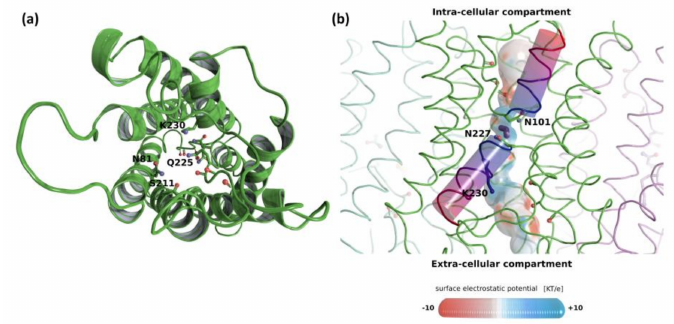
Figure 2. Structural analysis of Triat XIP. ( a ) Schematic representation of one protomer of Triat XIP as seen from the extra-cellular compartment. The backbone is represented in a diagram and the pore lining residues in sticks. Residues of the ar/R SF constriction are labeled. K230 is unusual as it replaces the very conserved Arginine of the constriction. ( b ) Schematic representation of the tetramer with a focus on one protomer for which the pore surface is figured. Electrostatic potential (KT/e) was computed with APBS (the atoms were previously typed with the PARSE forcefield in PDB2PQR) and projected on the pore surface. The channel surface has a typical positive potential at its NPA region, where the two hemi-helices (represented by cylinders) meet and in the extra-cellular vestibule because of the positively charged lysine 230 side-chain. A water molecule is figured in purple interacting with the two Asparagines of the NPA region. Local electronegative potentials are located at the interaction sites for water molecules with carbonyl groups of the backbone. The two Asparagines of the NPA region, the Lysine 230 of the ar/R constriction and the carbonyl groups of pore-lining residues are represented with sticks. All representations were made with PyMol software